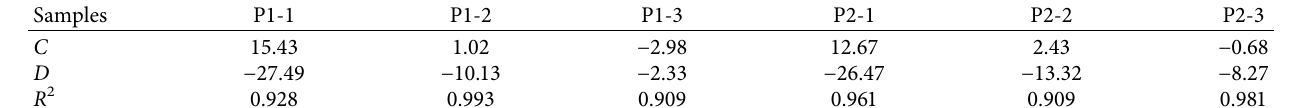
Table 4: Values of coefficients C and D and correlation coefficient R 2